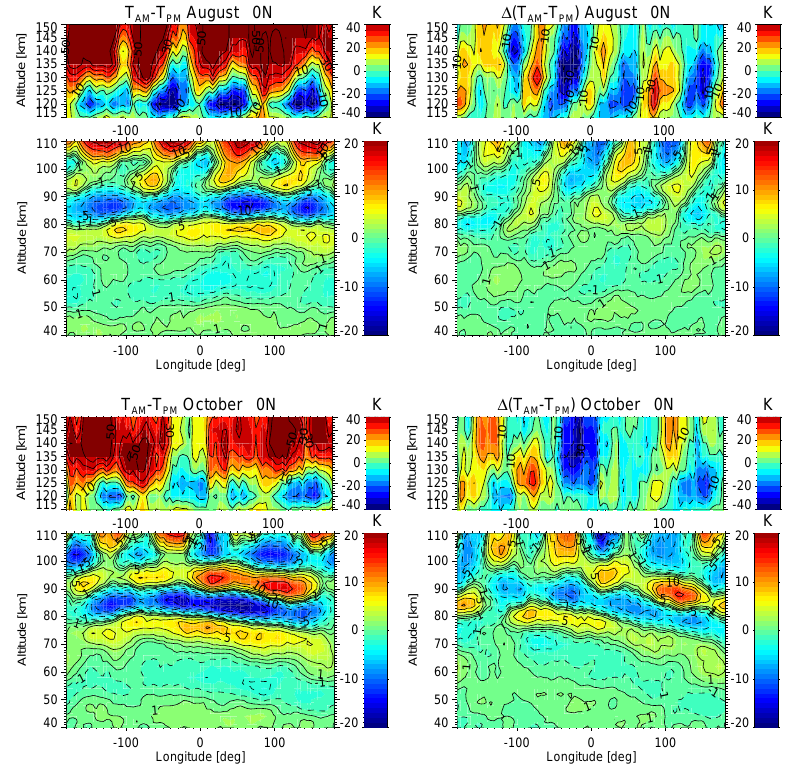
Figure 1. Equatorial MIPAS monthly mean temperature difference (left) and anomaly (with respect to the mean value at each altitude; right) of (cid:49)T/ 2 for August (first and second rows) and October (third and fourth rows) averaged for 2007–2012. Temperatures below 110km are retrieved from measurements at 15µm and above 115km from 5.3µm. Note the different color scales.